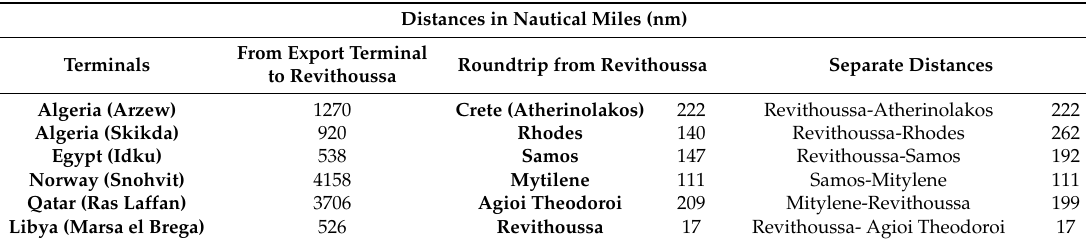
Table 7. The values of the criterion “Distance”